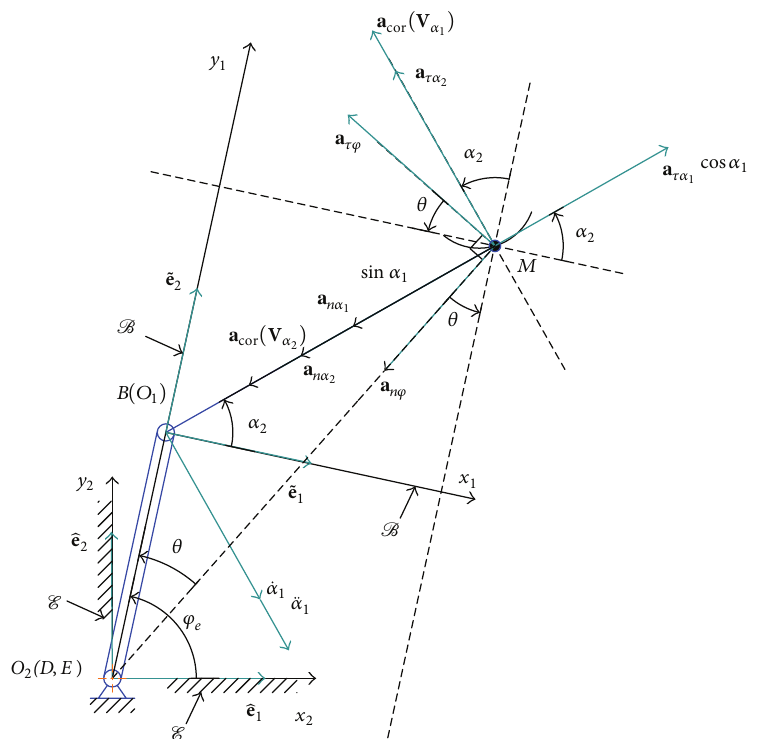
Figure 14: Swaying scheme for acceleration kinematics analysis in spherical coordinates of load 𝑀 at the cable 𝑀𝐵 , which is fixedly attached in the point 𝐵 to the crane boom 𝐵𝑂 2 , in the horizontal plane ( 𝑥 1 𝑦 1 ) for nonlinear model derivation in relative spherical coordinates.